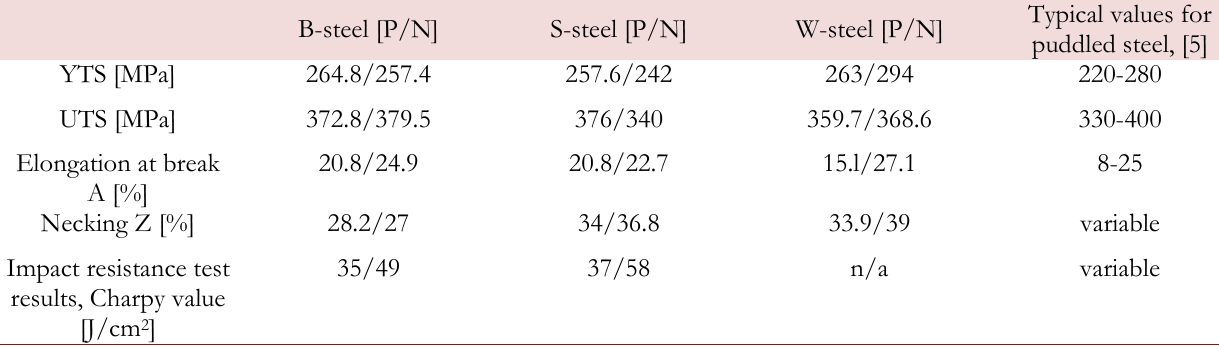
Table 2: Strength properties of the investigated materials in post-operating state (P) and after heat treatment – normalising (N).